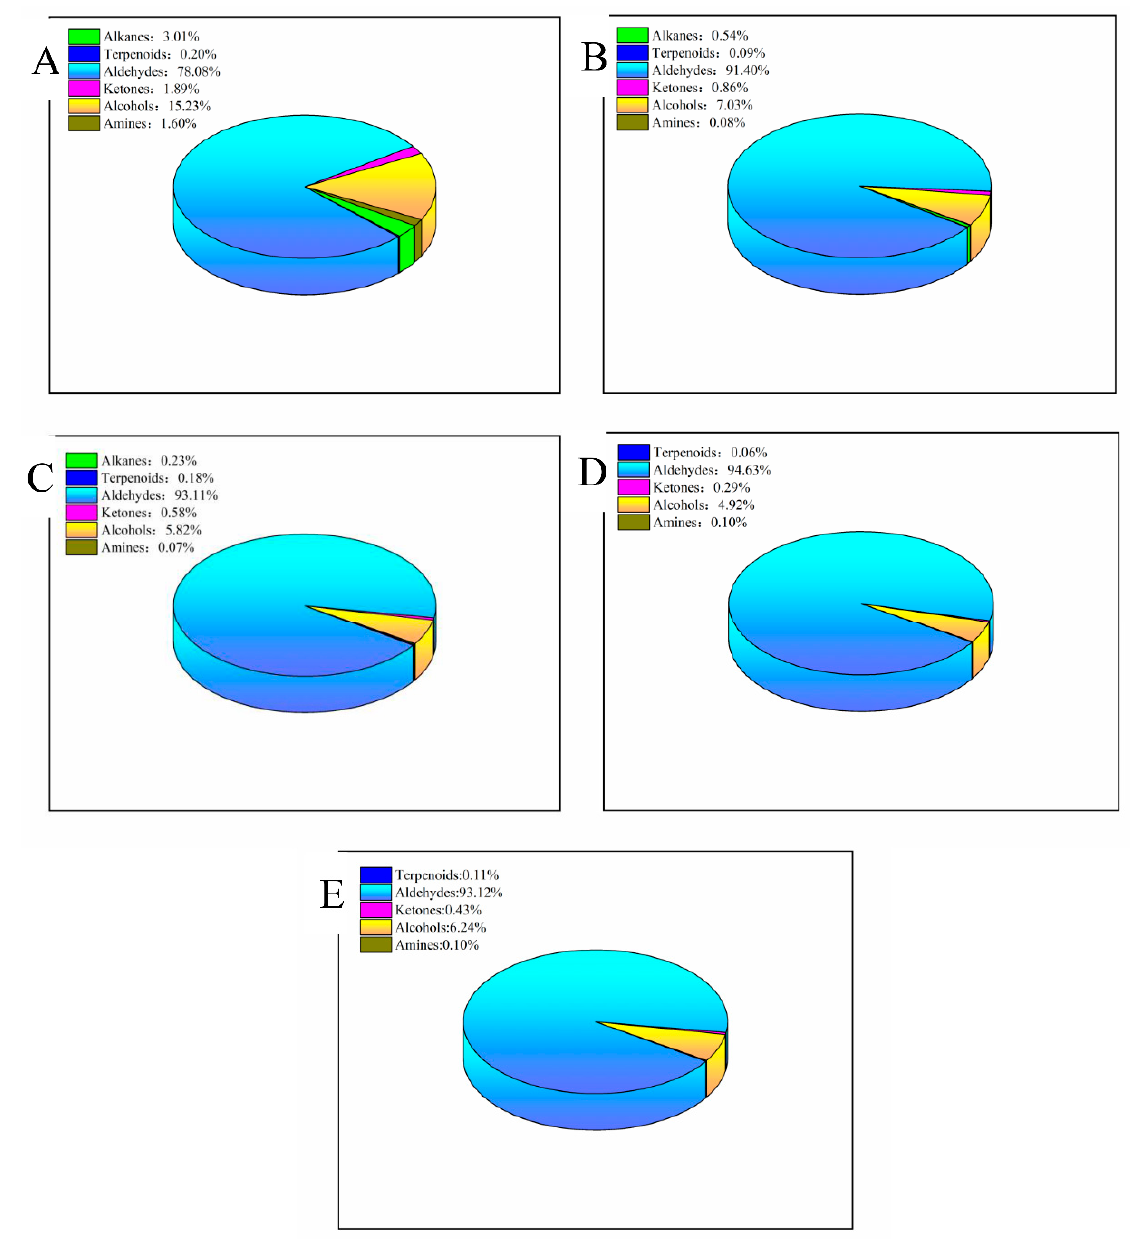
Figure 1. Distribution of volatile species and relative content of egg yolk under different ozone treatment times. ( A ) 0 min; ( B ) 10 min; ( C ) 20 min; ( D ) 30 min; ( E ) 40 min.